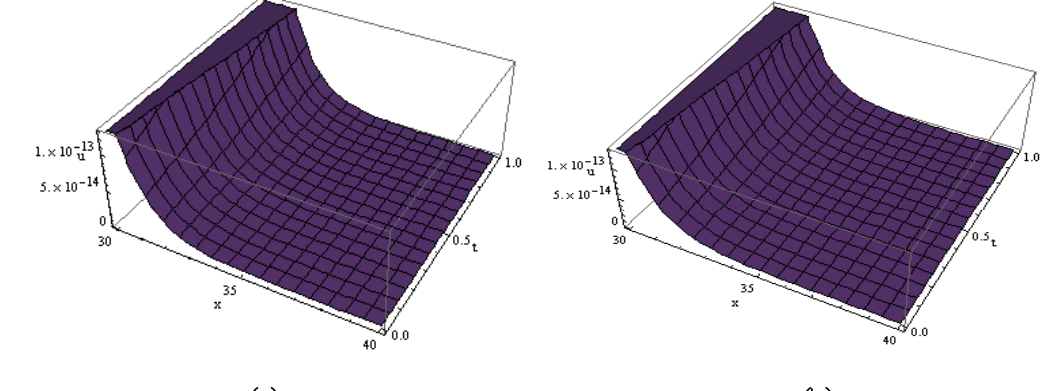
Figure 2. (a) computed of the seventh-order